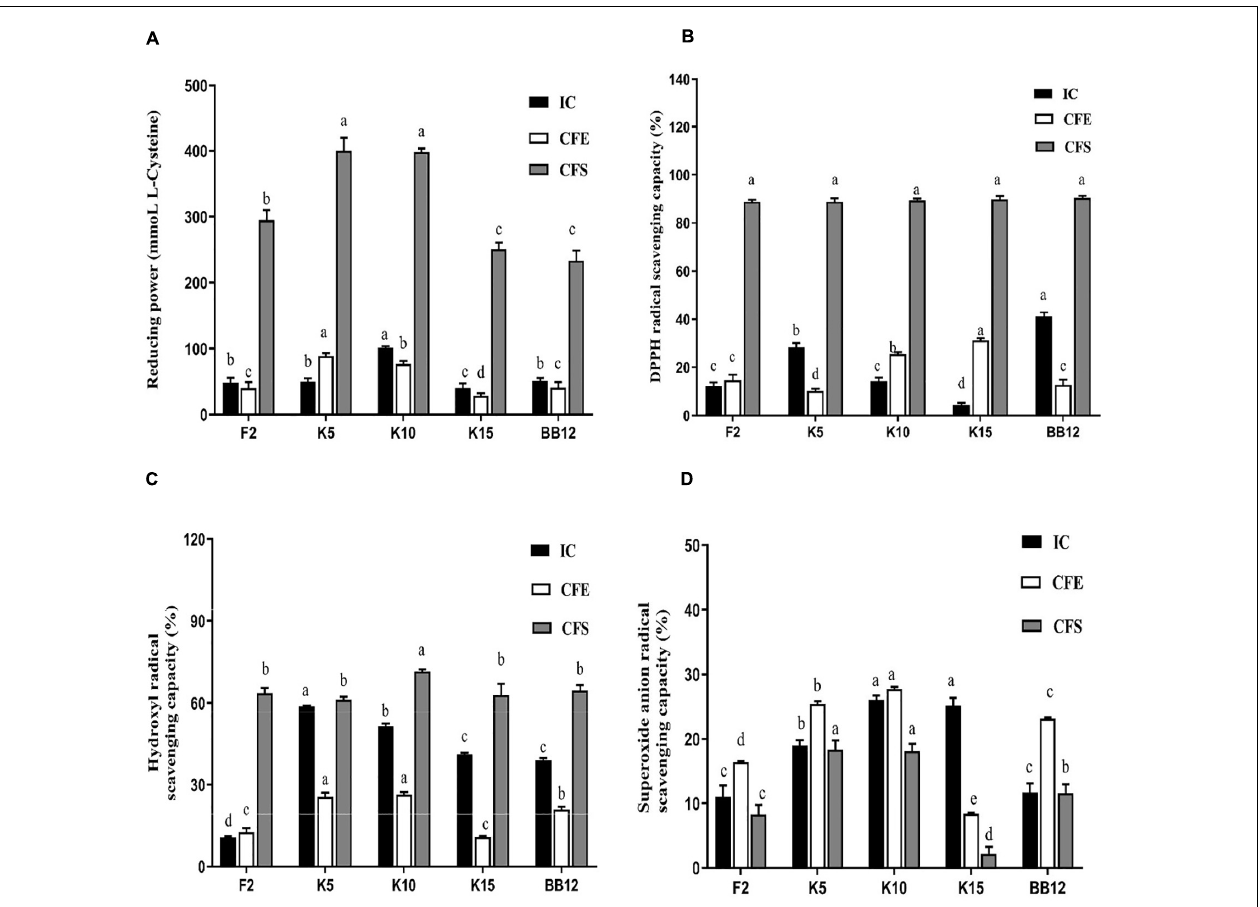
FIGURE 8 | Antioxidant properties of B. longum subsp. longum strains, including reducing power (A) , hydroxyl radical scavenging capacity (B) , DPPH radical scavenging capacity (C) , and superoxide anion radical scavenging capacity (D) . IC, intact cells; CFS, cell-free supernatant; CFE, cell-free extracts. P < 0.05 was considered to demonstrate statistically significant differences and recorded with different